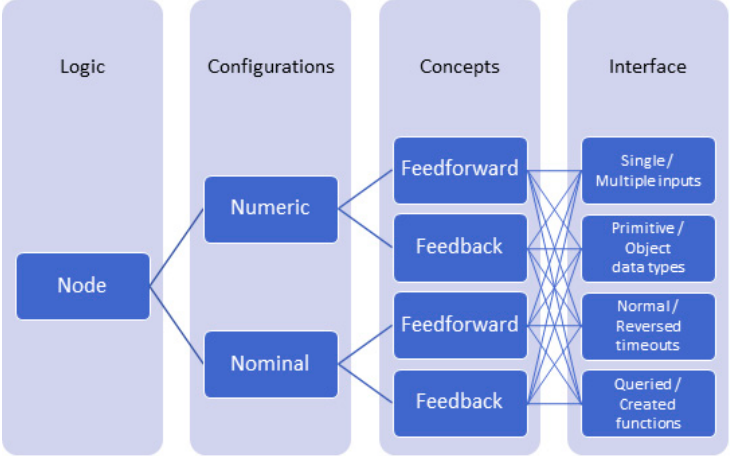
Figure 12. The conceptual scheme of the platform starts from the Logic level of the general node present on the server-side compiler, the JSON Configurations level corresponding to the decisional and formula statements, and the Concept level of nodes in the intuitive no-code templates and ends with the Interface level, which offers the hand-on tools for applet creation by non-programmers.